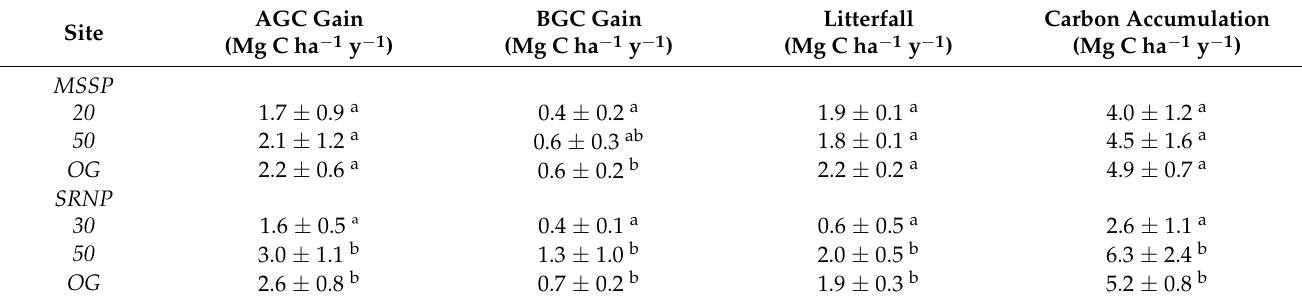
Figure 2. Initial and final aboveground biomass (AGB) and belowground biomass (BGB) at each forest stand (20, 30 and 50-year-old and old-growth = OG) in Mata Seca State Park (MSSP) and Scheme 0. According to one-way ANOVA and a Tukey test. Table 1. Changes in aboveground carbon (AGC) and belowground carbon (BGC), litterfall production, and carbon accumulation averaged per forest stand (20, 30 and 50-year-old and old-growth = OG) for Mata Seca State Park (MSSP) and Santa Rosa National Park